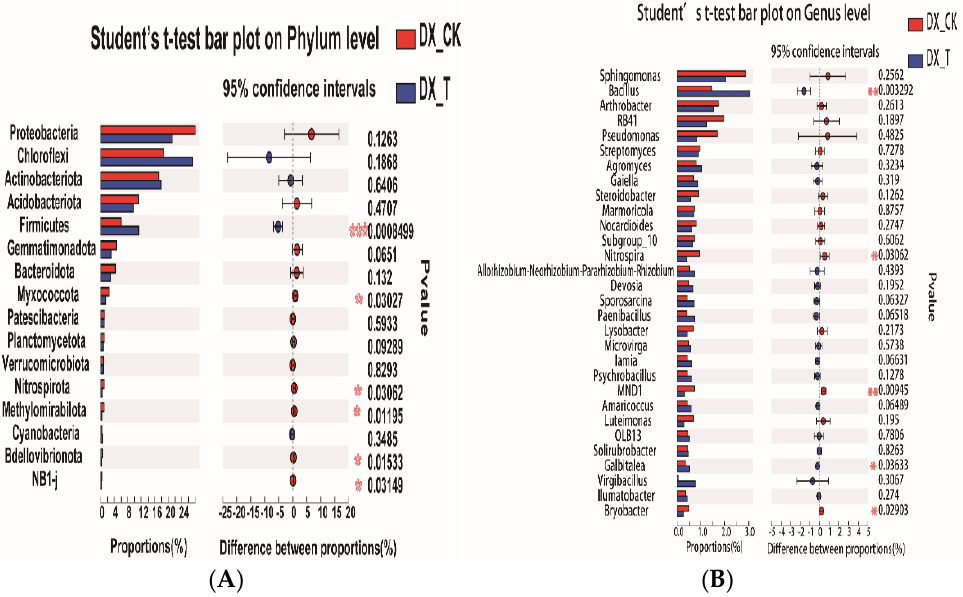
Figure 7. Changes in the relative abundance of bacterial ( A ) phyla and ( B ) genera in triple-fumigated soil that had been used to produce watermelon. ‘Triple fumigation’ refers to the simultaneous application of chloropicrin, dimethyl disulfide and metham sodium. The t -test reported the statistical differences (asterisked, * 0.01 < p ≤ 0.05; ** 0.001 < p ≤ 0.01; *** p ≤ 0.001.) between the means of three replicates within the phylum or genus levels.